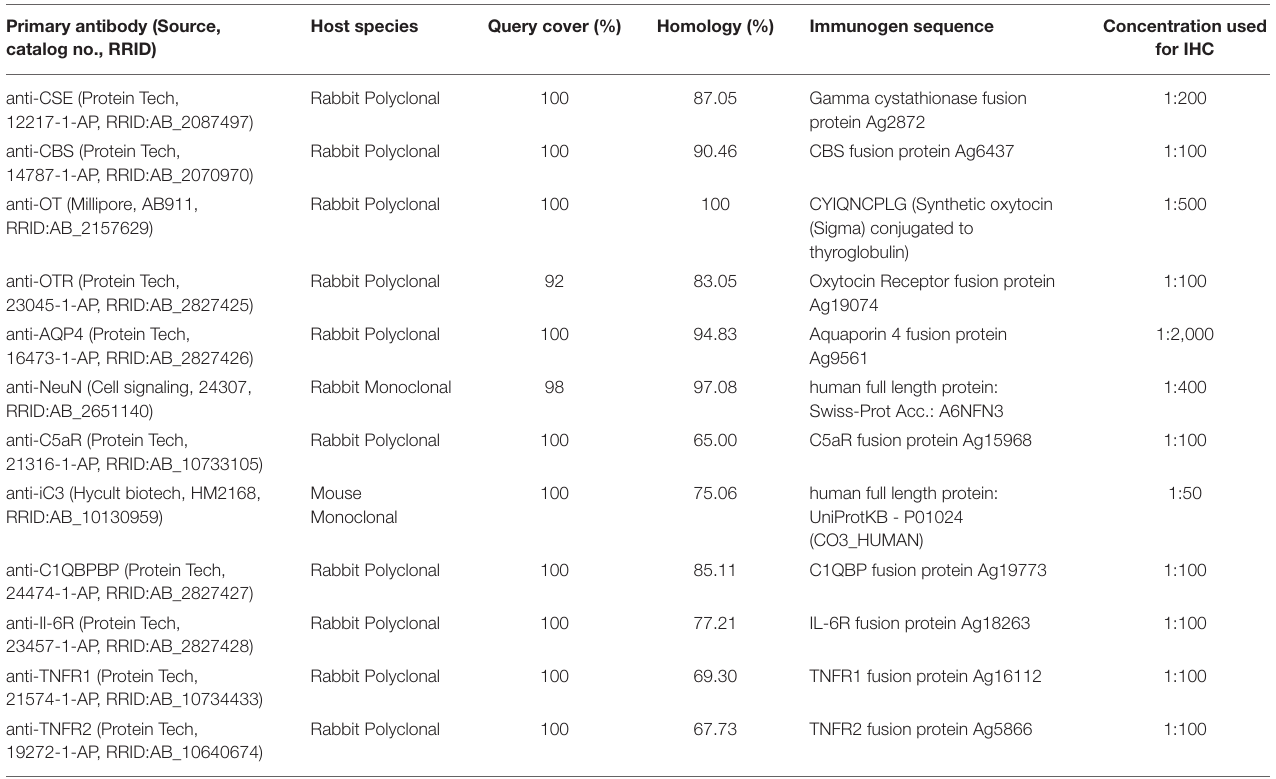
TABLE 1 | Protein BLAST search for primary antibodies (anti-human) to sus scrofa. Primary antibody (Source, Host species Query cover (%) Homology (%) Immunogen sequence Concentration used catalog no., RRID)